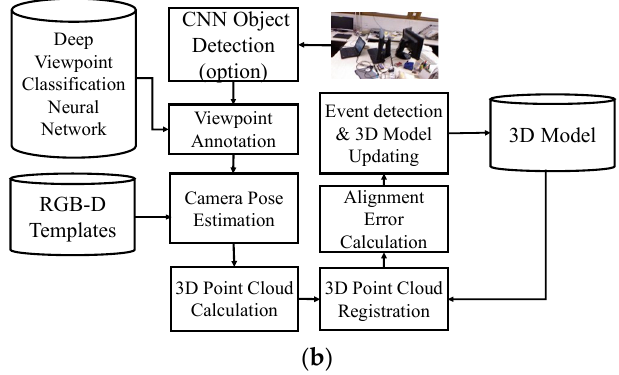
Figure 1. The workflow of the proposed 3D scene modeling for model updating using a single RGB image: ( a ) the 3D scene modeling; ( b ) the model updating approach. The CNN object detector is an optional operator which is used only when the target scene to be modeled is an object.